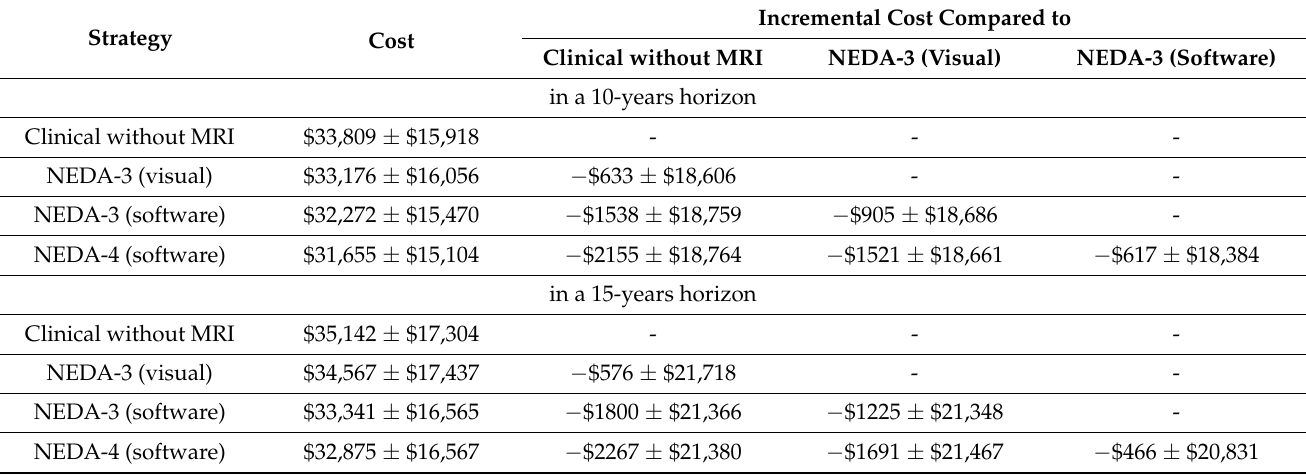
Table 5. Annual costs related to health status (in US$ 2021) and incremental costs per patient compared between strategies.